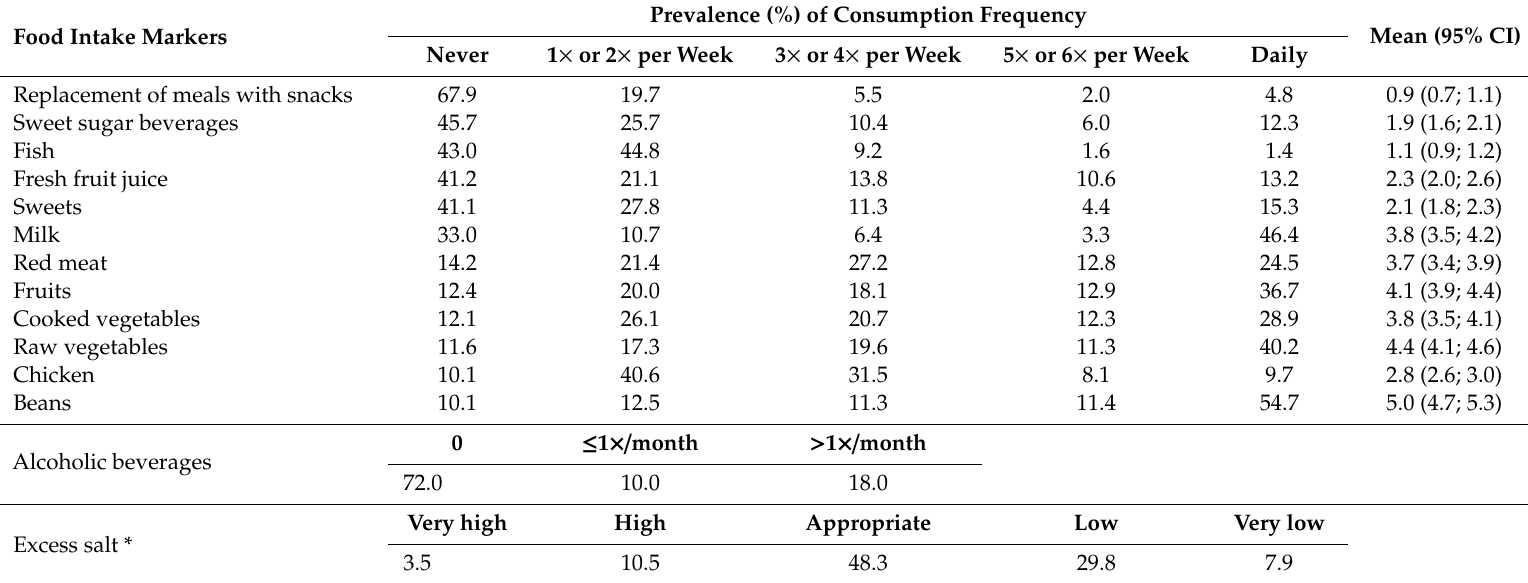
Table 3. Mean and prevalence (%) of consumption frequency of food intake markers in individuals with CKD from the Brazilian NHS, 2013 ( n = 839). Food Intake